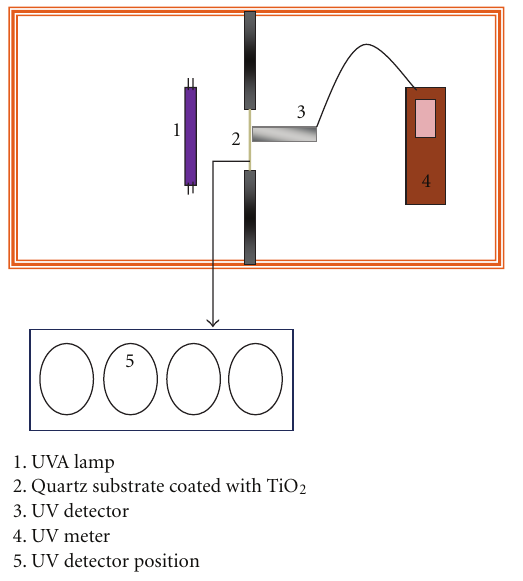
Figure 2: Schematic diagram for the UVA transmission measure- ment apparatus.